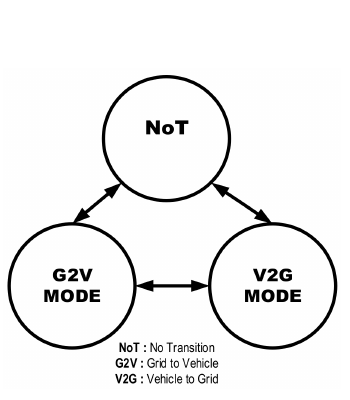
Figure 3. Possible transitions of an EV. Table 2. Transition probabilities at a given time interval.